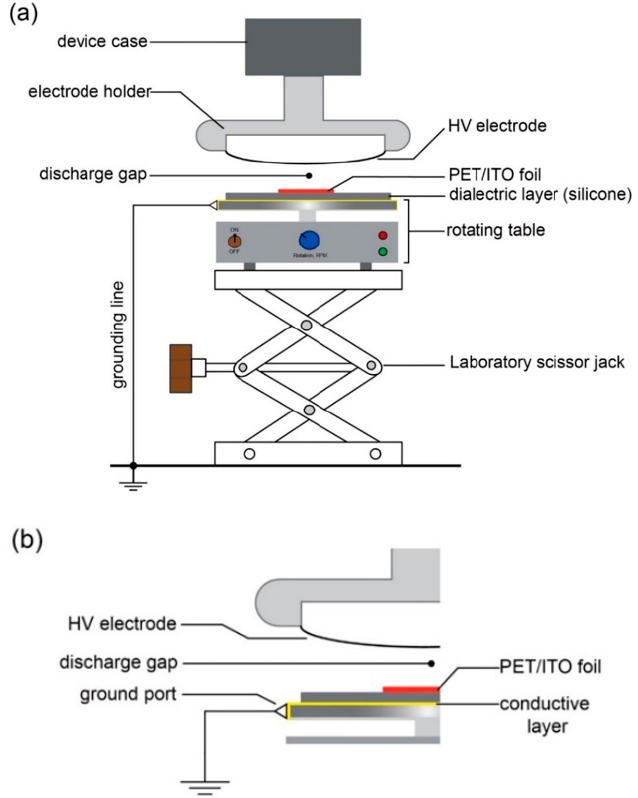
Figure 3. Scheme of the experimental setup for the DBD modification used in our experiments: ( a ) The sample poly(ethylene terephthalate) (PET) covered with a layer of indium tin oxide (ITO) (PET/ITO foil) was placed on a silicone dielectric isolator, which is on the top of a rotating table. The rotation ensures an even and uniform degree of modification of the surface of the sample. The table is placed on the top of a laboratory scissor jack to regulate the distance between the high voltage (HV) electrode and the PET / ITO foil. ( b ) To connect the bottom electrode to the ground, the rotating table was covered with conductive metal layer (copper tape) and a ground port made of an elastic stainless-steel needle was connected with the grounded metal element.